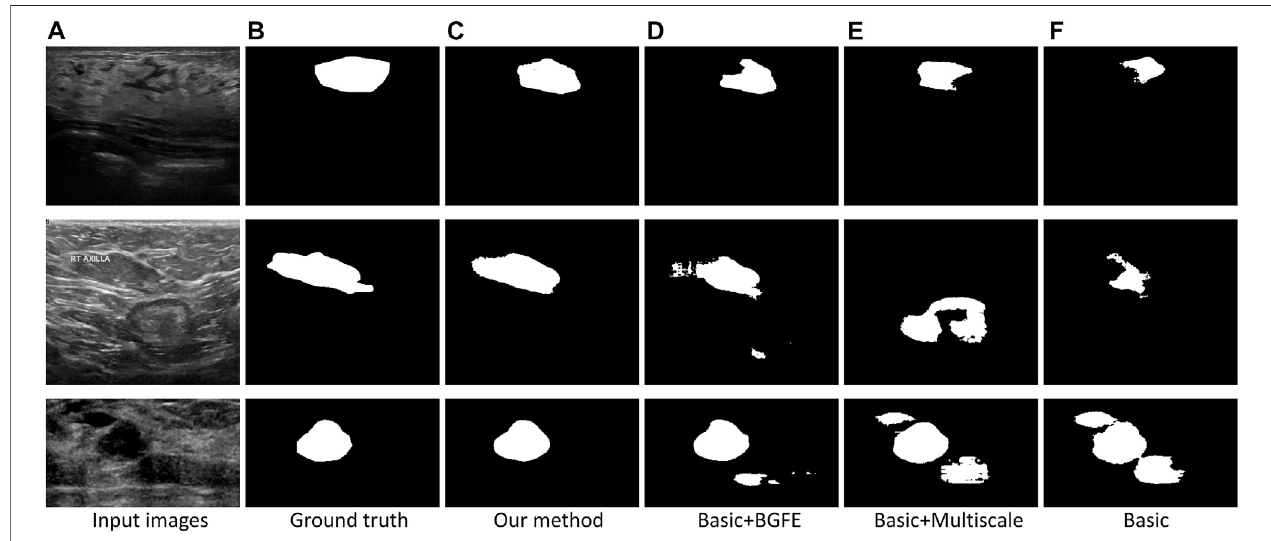
FIGURE 5 | Comparison of breast lesion segmentation between our approach (C) and the three baseline networks (D – F) against the ground truth (B)